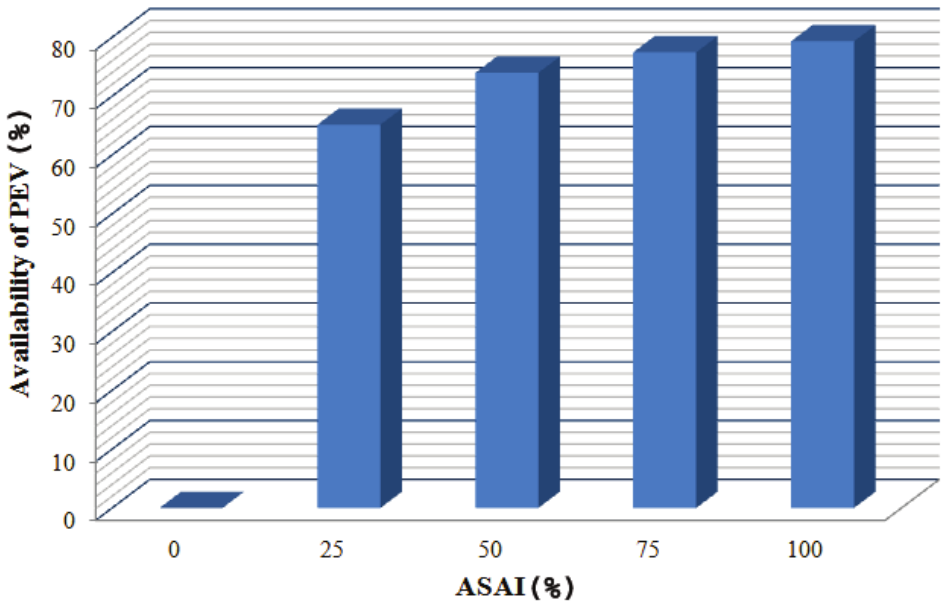
Figure 10. Availability of PEV at different Average Service Availability Index